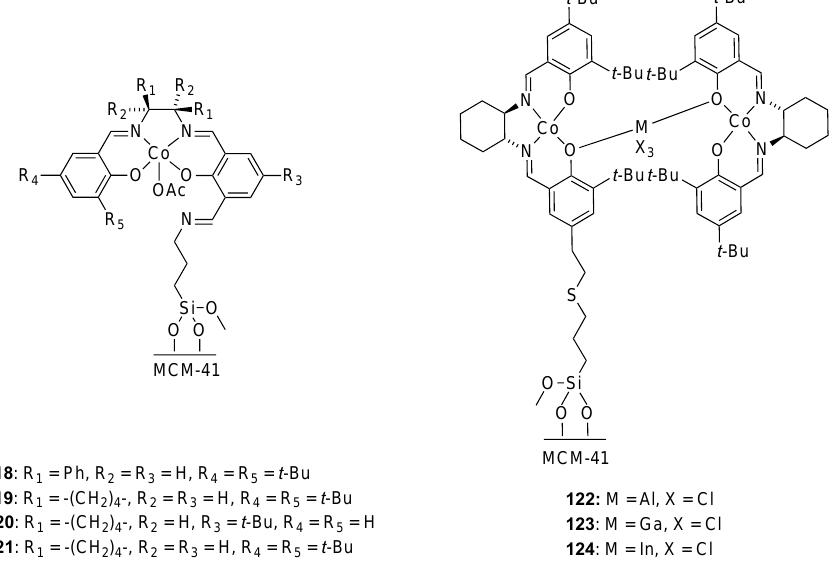
Figure 47. MCM-41-supported salen catalysts 118 – 124 .